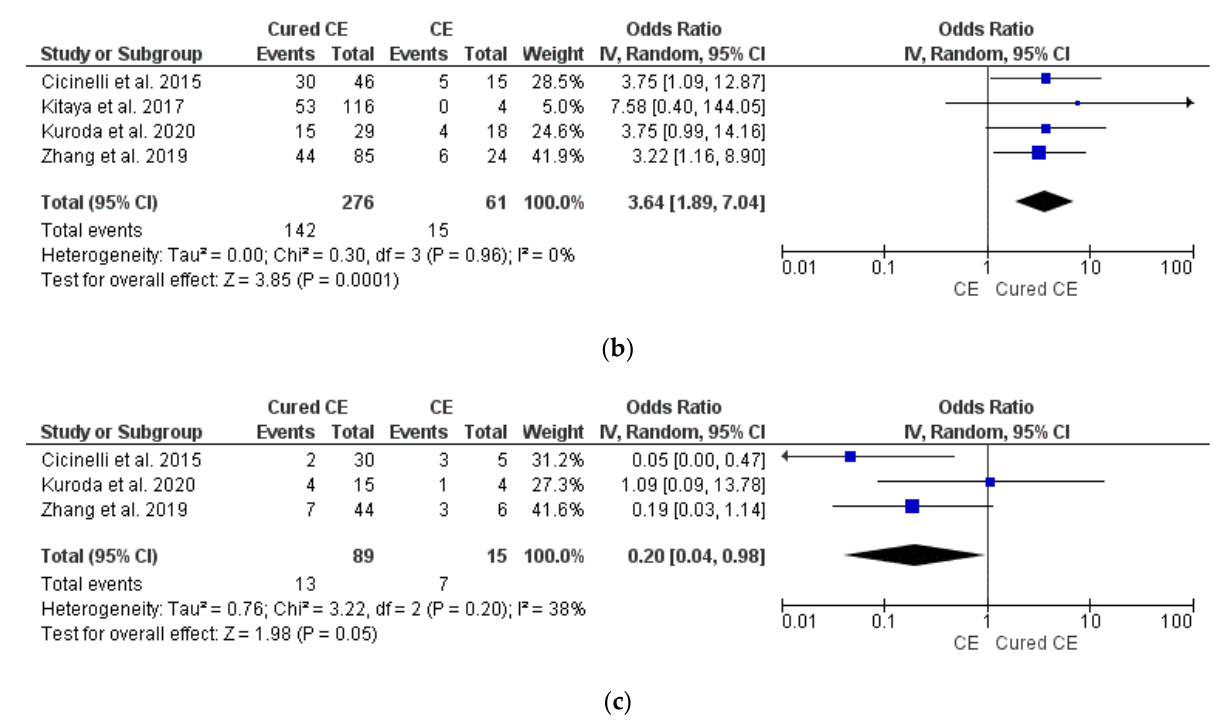
Figure 3. Pooled data analysis comparing CE versus cured CE: ( a ) ongoing pregnancy rate/live birth rate; ( b ) clinical pregnancy rate; ( c ) miscarriage rate [4,8,12,34].